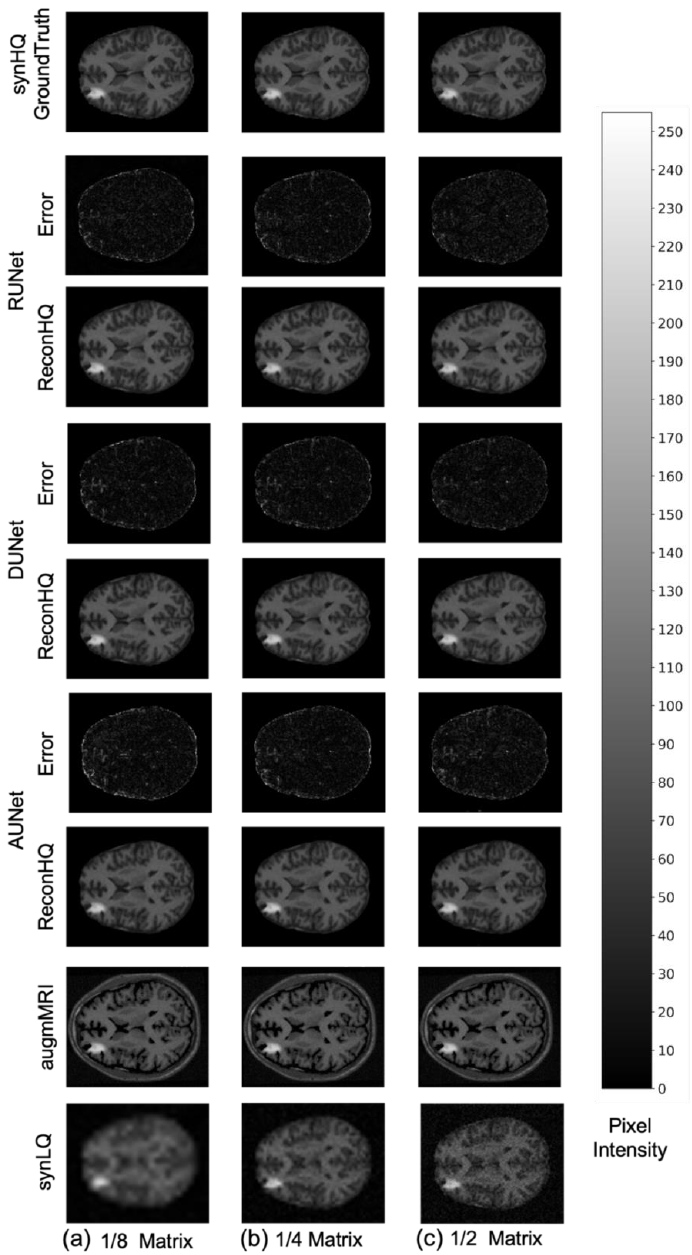
Figure 7. Representative example of reconstructed images and errors versus ground truth with the three UNets trained for 100 epochs with the With-Prior acquisition scenario (i.e., including the augmMRI) to upscale ( a ) 1/8 downsampled (22 × 26) and ( b ) 1/4 downsampled (44 × 52) and ( c ) 1/2 downsampled (88 × 104) synLQ. The Error intensity in this figure is five times the original intensity.